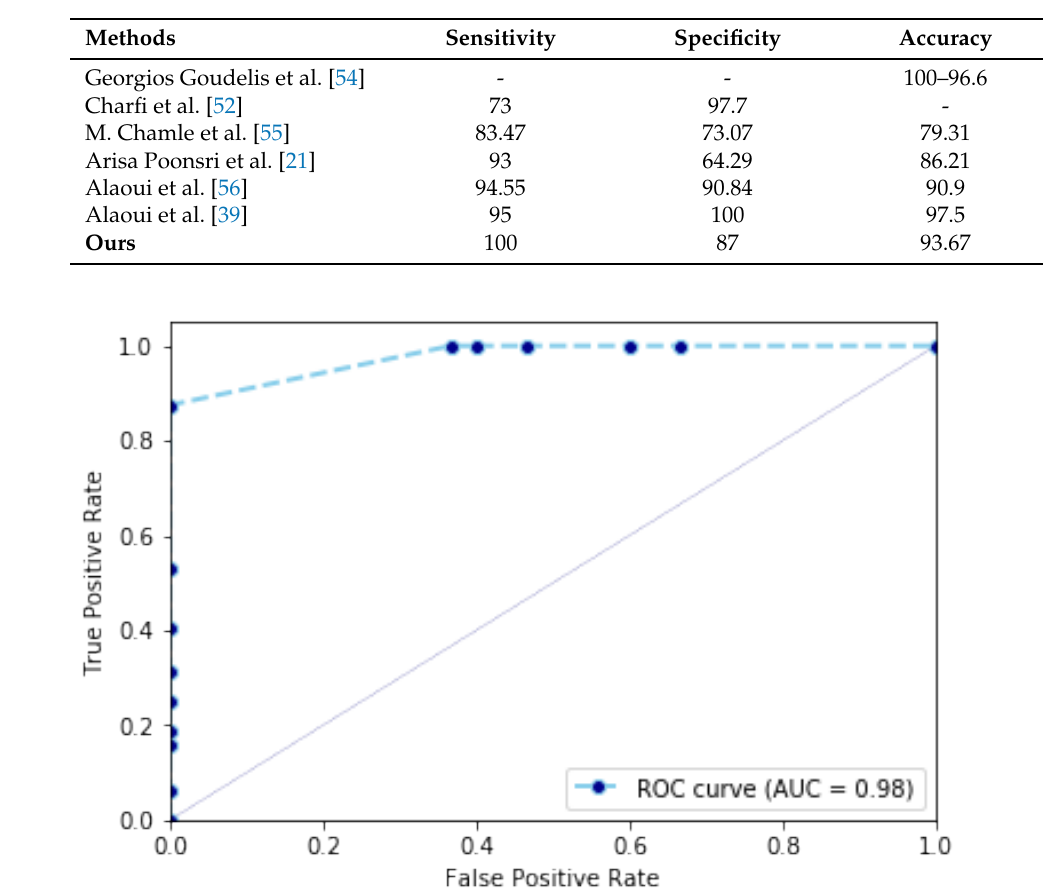
Figure 5. Charfi dataset: ROC curve representing the cumulative rate between true positive rate and false positive